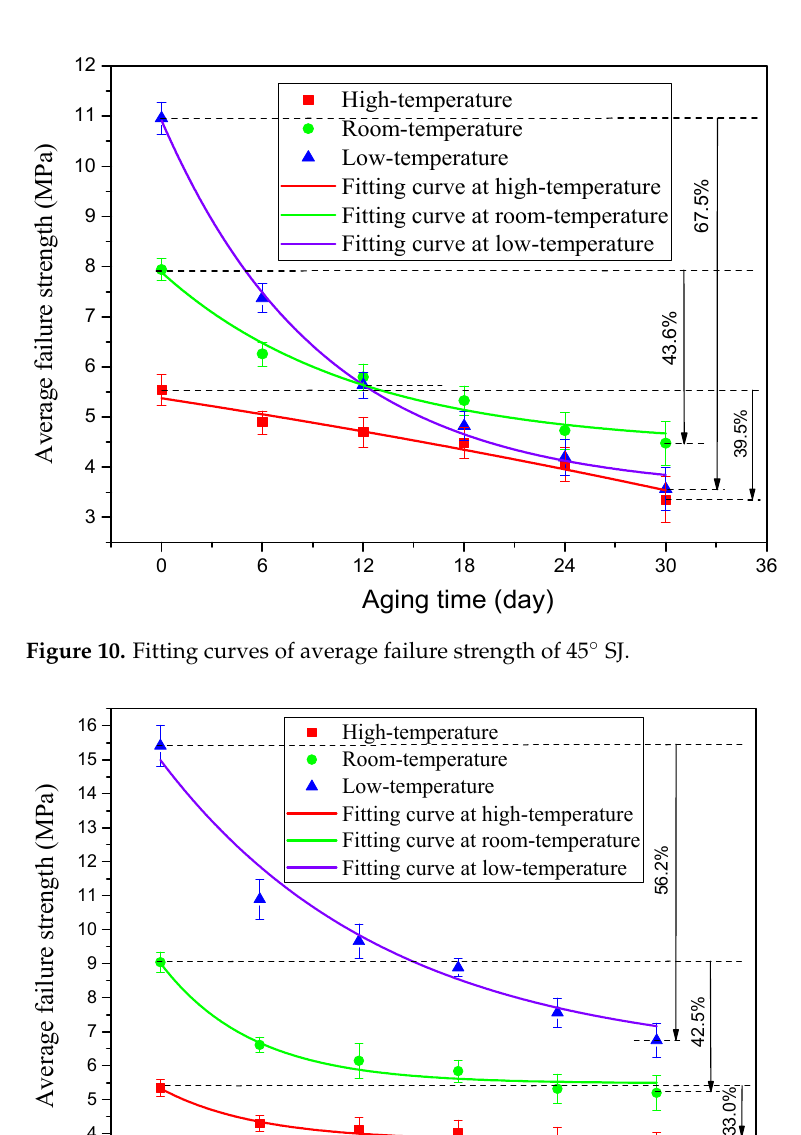
Figure 9. Fitting curves of average failure strength of BJs.